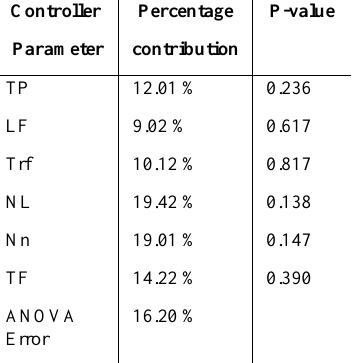
Figure 5. Main effects plot for SNRs. Table 4. Percentage contribution.